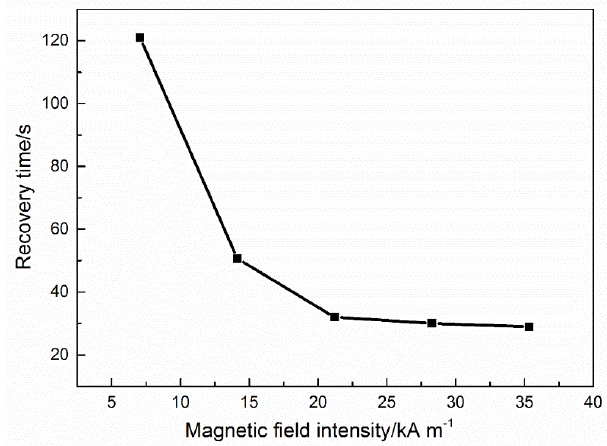
Figure 7. Relation between recovery time and magnetic field intensity of the 13.5 wt % Fe 3 O 4 /SBS/LLDPE composite.